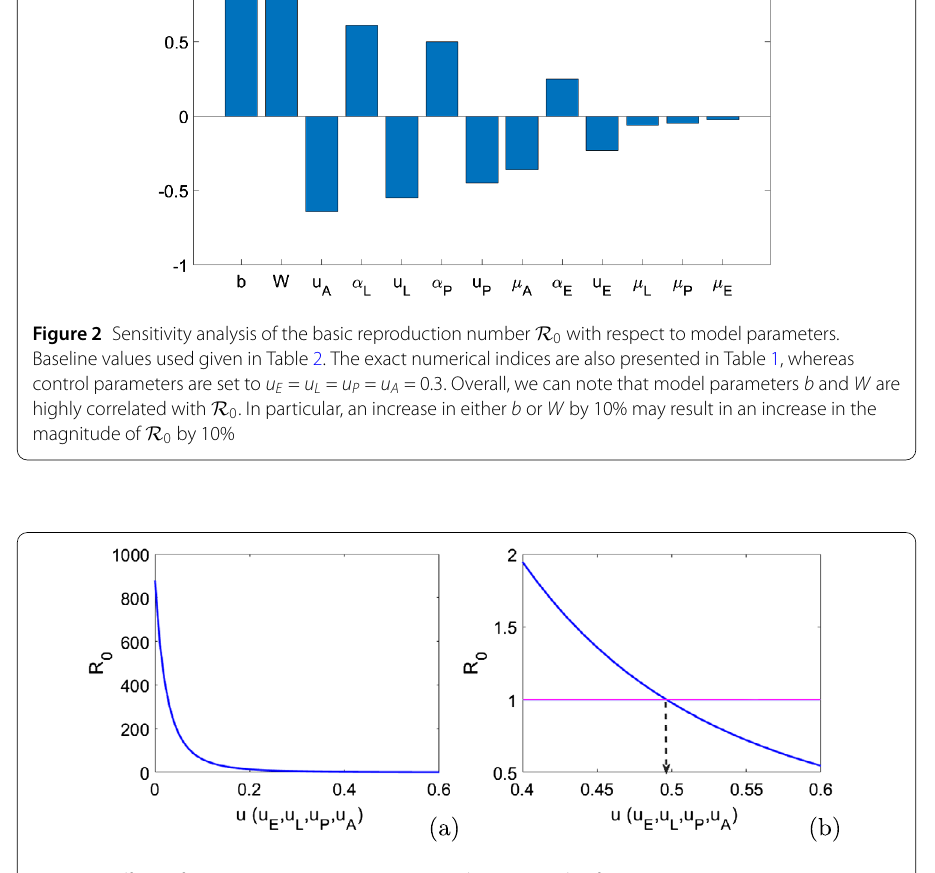
Figure 3 Effects of varying intervention strategies on the magnitude of R 0 . Here we set u = u E , u L = u P = u A . ( a ) Dynamics of R 0 on a wide ranges of values for u . ( b ) Zoomed graph, that is, an illustration of the dynamics of R 0 for a refined range of values for u . From the results we can note that any value of u > 0.5 leads to the extinction of the pest, and persistence of the pests occurs for u <